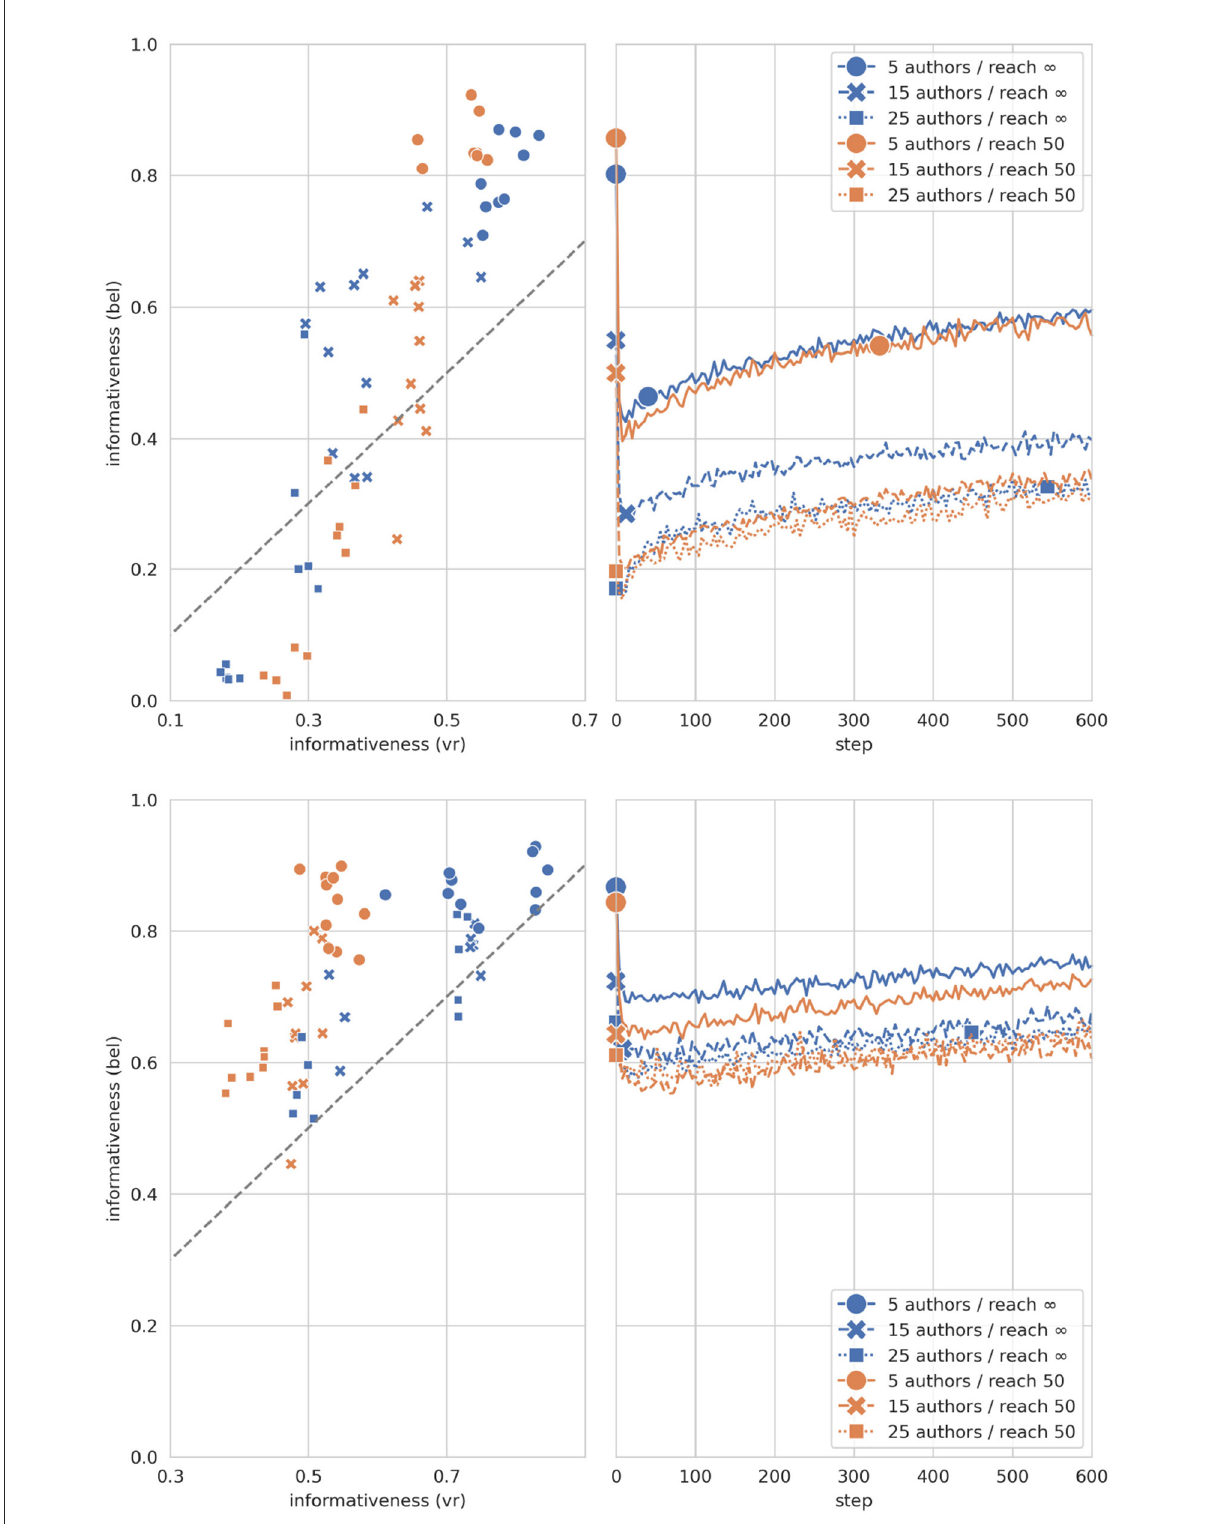
FIGURE4 Initial over- and under-confidence (scatter-plots), and informativeness evolution during self-training (line-plots). Top : corpora with high inter-author diversity ( kendall_tau < 0.055); bottom : corpora with low inter-author diversity ( kendall_tau > 0.055). In the scatter-plots , each marker represents a single pre-trained model, which exhibits over-confidence (under-confidence) if and only if its marker lies well above (below) the dotted diagonal. In the line-plots , the shown trajectories average over all models with the same number of agents and same reach threshold; the first marker designates the mean initial doxastic informativeness, the second one marks the step from which on mean doxastic informativeness is greater than average initial vote ratio